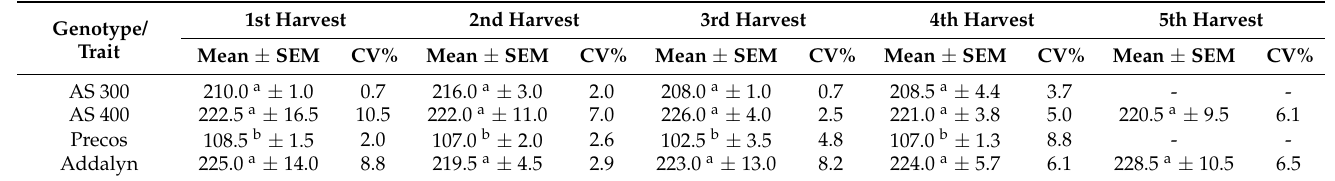
Table 2. The average weight of the tomato fruit (g) at different harvests during an annual production